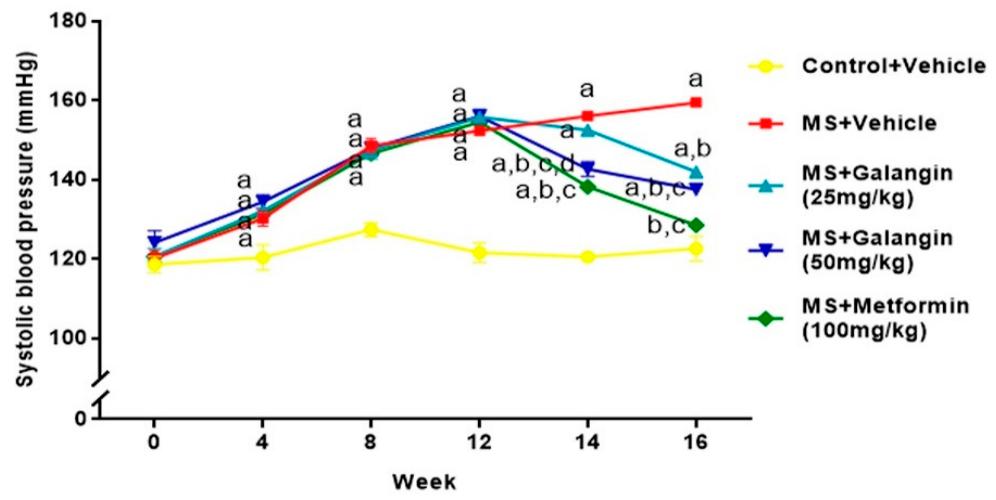
Figure 3. Effects of galangin and metformin treatments on systolic blood pressure. Data are presented as the mean ± S.E.M. ( n = 8). a p < 0.05 vs. the control group, b p < 0.05 vs. the MS group, c p < 0.05 vs. the MS + galangin (25 mg/kg) group, and d p < 0.05 vs. the MS + galangin (50 mg/kg) group. Table 3 . Effects of galangin on blood pressure obtained from a direct method of blood pressure measurement in rats with high-fat diet-induced metabolic syndrome.